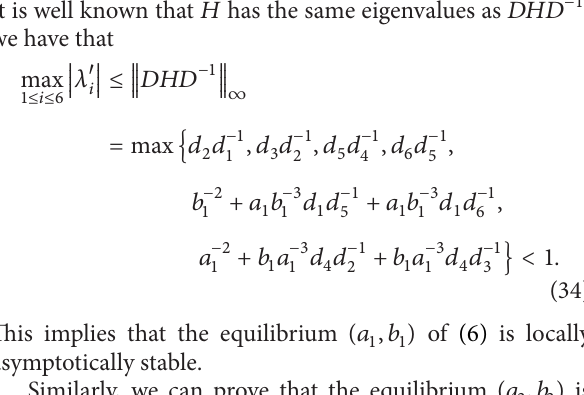
Figure 1: The dynamics of system (35) at 𝐴 = 2.4 .